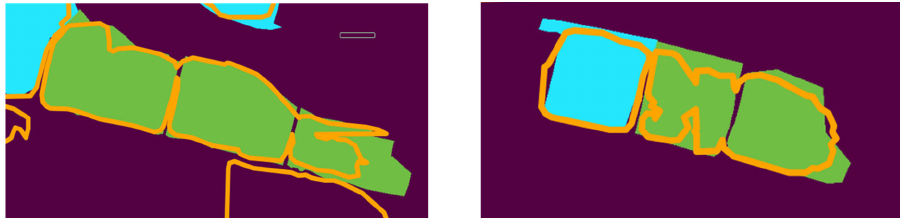
Figure 24. False negatives due to incorrect merging of multiple instances into a single